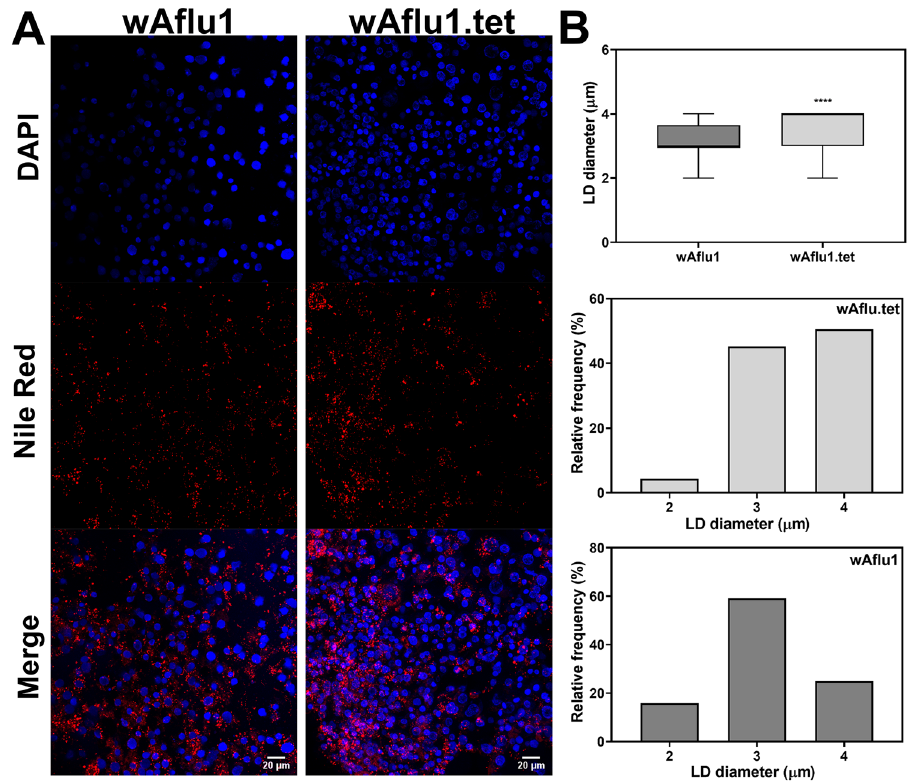
Figure 5. wAflu1 cells have smaller lipid droplets lipid droplets than w Aflu1.tet. Cells were stained with Nile Red and DAPI and observed under a laser scanning confocal microscope ( A ). wAflu1 cells show smaller lipid droplet (LD) average diameter and higher relative frequency of smaller LD, while wAflu1.tet has higher relative frequency of larger LD ( B ). Maximum diameters of lipid droplets (LD) were determined from 3 independent experiments. Results were obtained from 208 to 301 LDs per group. (****) p < 0.0001 by Student’s t- test. Scale Bar: 20